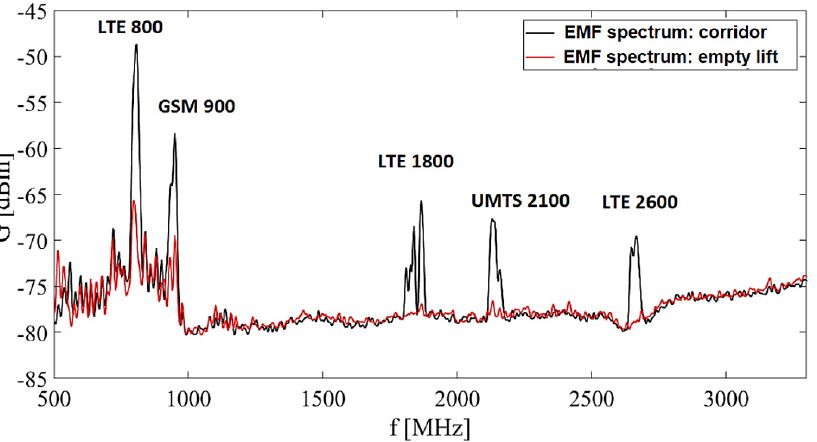
Figure 7. Experimental results: EM field received power spectrum in region of interest, individual sources.